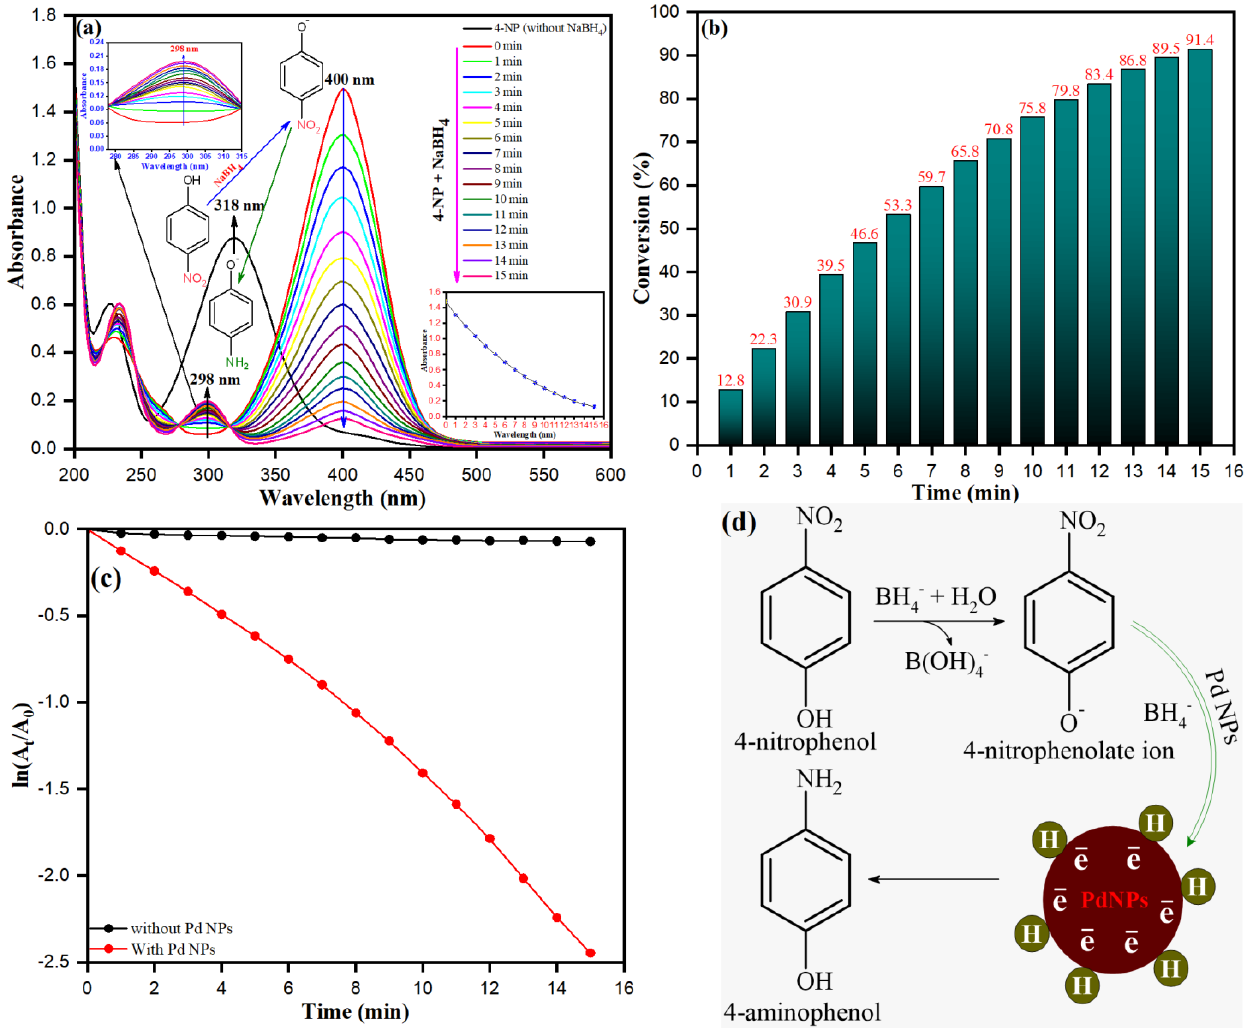
Figure 13. ( a ) The UV–vis absorption spectrum of 4-NP, ( b ) Conversion percentage of 4-NP to 4-AP, ( c ) Kinetic plot for the reduction of 4-NP into 4-AP, and ( d ) Possible conversion mechanism of 4-NP into 4-AP in the presence of PdNPs. (Experimental conditions: (4-NP) = 0.5 × 10 − 4 M, (NaBH 4 ) = 1.0 × 10 − 3 M, PdNPs = 4 mg, Temperature = 30 ◦